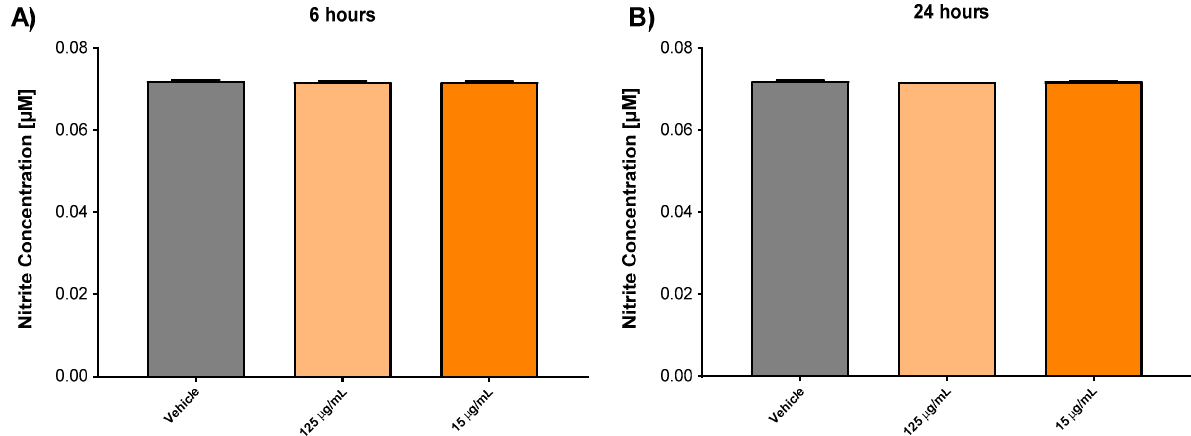
Figure 6. Effect of haloarchaea biomass on the secretion of nitrites in HaCaT skin cell line. The figure shows HaCaT cells cultivated with biomass of the strains Halorubrum tebenquichense Te Se-86 for 6 and 24 h of stimulus. The secretion of nitrites was evaluated by Griess assay, quantified as a concentration calculated in µM. ( A ) Nitrite concentration after 6 h of stimulus. ( B ) Nitrite concentration after 24 h of stimulus. Bars indicate mean ± SD, p < 0.05, using a Kruskal–Wallis statistics test.